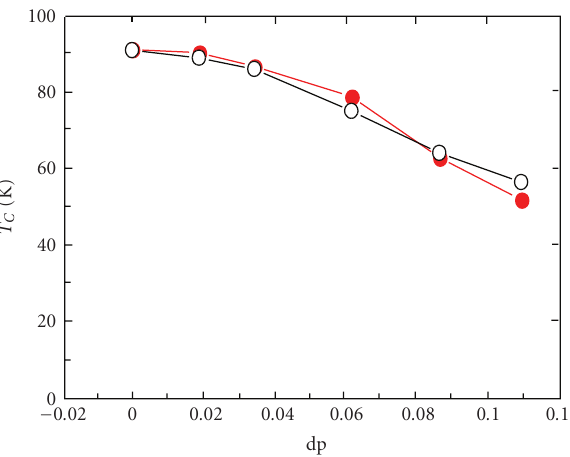
Figure 3: Comparison of the variation of T C with the variation of the doping dp from the optimum doping at dp = 0, calculated in our model (red filled circles) and the experimental results of Koike et al. (black open circles)